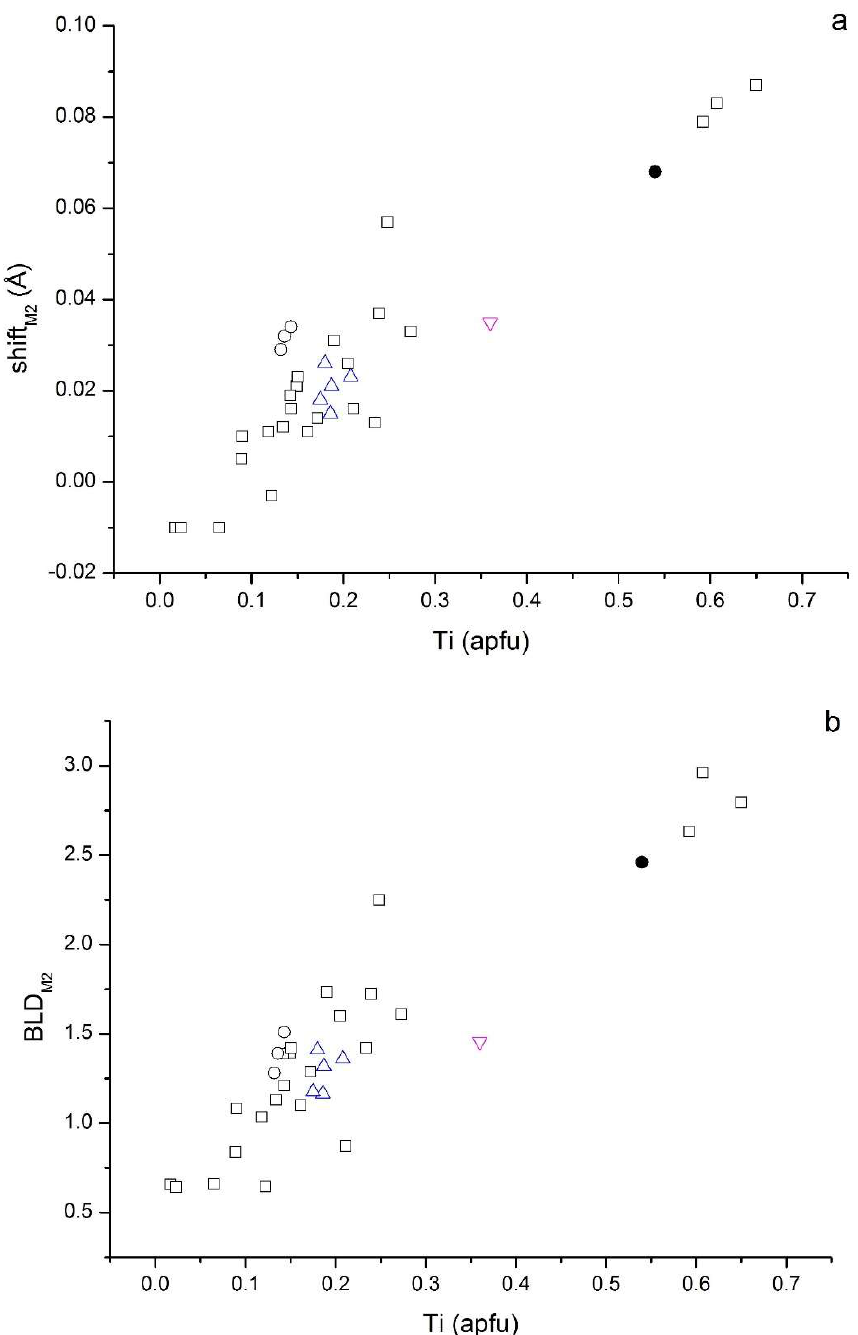
Figure 5. ( a ) Plot of the off-center shift of the cation within the M2 site vs. VI Ti content; ( b ) plot of edge length distortion parameter of octahedral M2 site vs. VI Ti content. Symbols: open squares from Cruciani and Zanazzi [17]; open circles from Cesare et al. [26]; up-pointing triangles from Scordari et al. [44]; down-pointing triangle from Schingaro et al. [27]; filled circle this study.